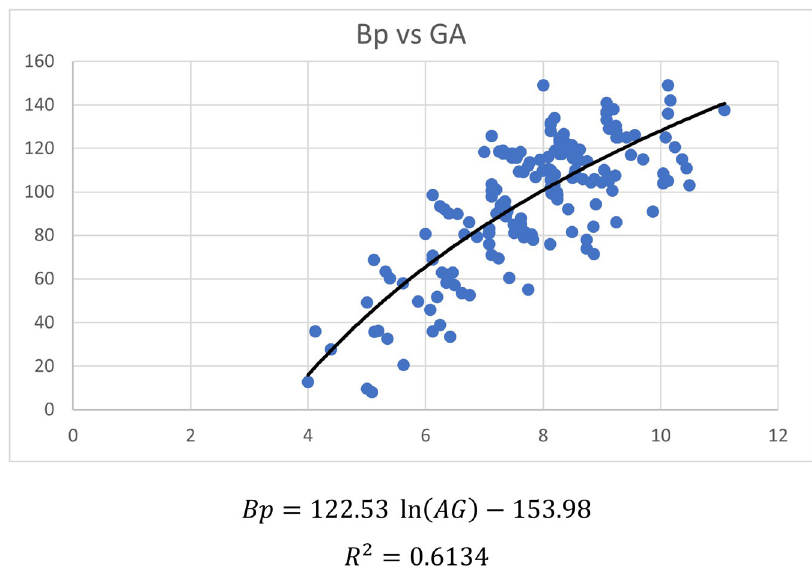
Figure 4: Logarithmic regression Bp versus AG .